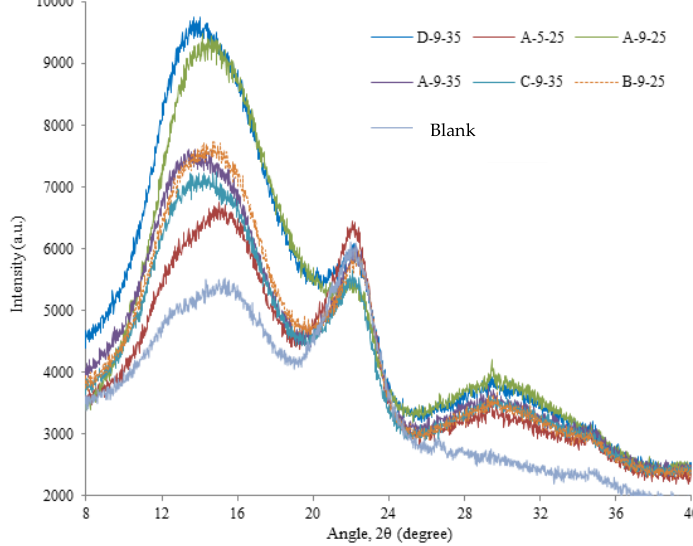
Figure 3. X-ray diffraction (XRD) patterns of the samples before/after combined pretreatment. A-5-25: 2% NaOH at 80 °C for 2 h and the ozone initial pH 5 for 25 min. A-9-25: 2% NaOH at 80 °C for 2 h and the ozone initial pH 9 for 25 min. A-9-35: 2% NaOH at 80 °C for 2 h and the ozone initial pH 9 for 35 min. B-9-25: 2% NaOH at 80 °C for 3 h and the ozone initial pH 9 for 25 min. C-9-35: 2% NaOH at 60 °C for 2 h and the ozone initial pH 9 for 35 min. D-9-35: 2% NaOH at 80 °C for 4 h and the ozone initial pH 9 for 35 min. Blank: untreated degreased stover.